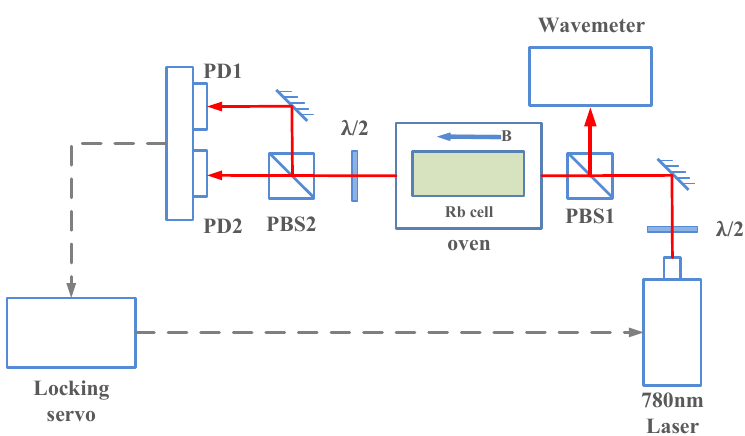
Figure 4. Experimental setup. PBS: polarizing beam splitter; λ /2: half wave plate; PD: photo detector. (Figure reproduced from [52].)